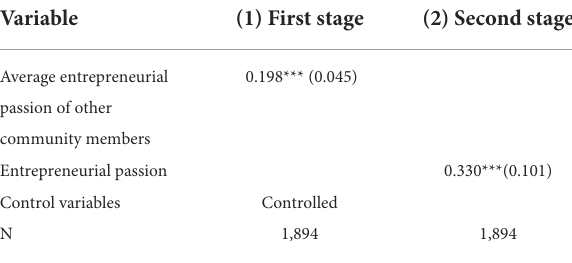
TABLE 11 Instrumental variable testing results (life satisfaction).